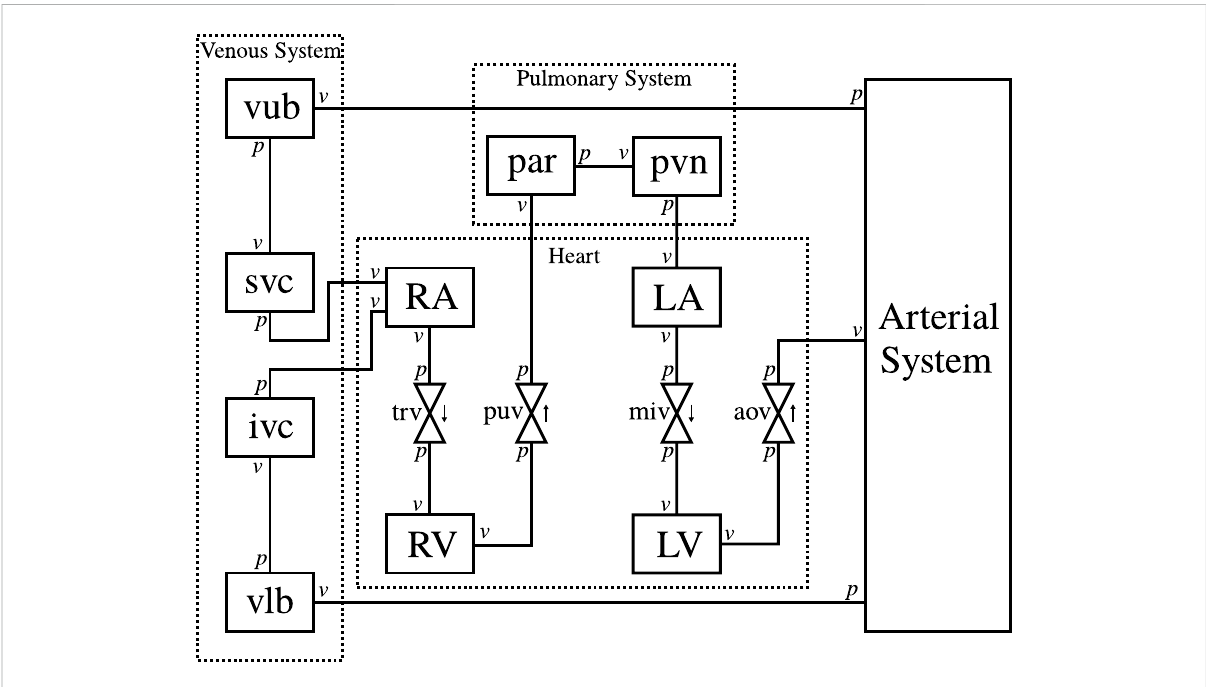
FIGURE 1 Schematic of the circulatory system model. RA, right atrium, RV, right ventricle, LA, left atrium, LV, left ventricle, trv, tricuspid valve, puv, pulmonaryvalve,miv,mitralvalve,aov,aorticvalve,par:pulmonaryartery,pvn:pulmonaryvein,vub,venousupperbody,svc,superiorvenacava,vlb, venous lower body, ivc, inferior vena cava, v , fl ow boundary condition, p pressure boundary condition.